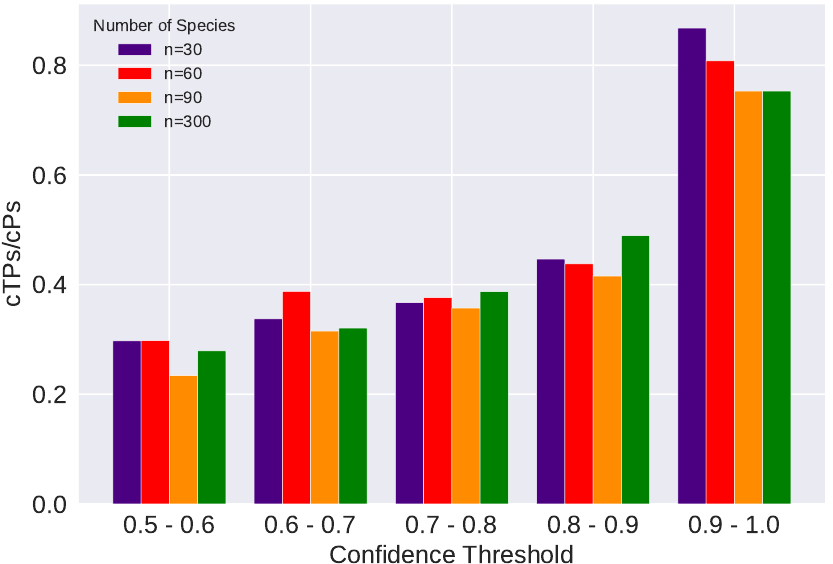
Figure 6. The precision (cTPs/cPs) increases as the confidence threshold (probability a sample needs to be assigned by the model in order for it to be classified as a positive prediction) is varied between 0.5 and 1.0. Shown are precision values for n = 30,60,90, and 300. As we can see for different n , as the confidence threshold tends toward 1.0, the precision also increases